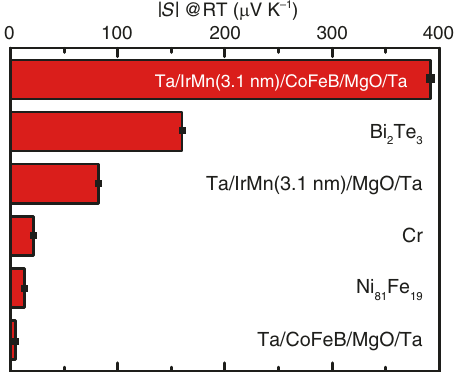
Fig. 5 Seebeck coef fi cients of various materials. The Seebeck coef fi cient of IrMn-based magnetic multilayer in comparison with conventional thermoelectric materials and magnetic materials in absolute value at room temperature. The values for Bi 2 Te 3 , Cr and Ni 81 Fe 19 are taken from refs. 5,13,44 respectively. A direct comparison of the Seebeck voltage measured as a function of temperature on multilayer samples with and without CoFeB layer is shown in Supplementary Note 14 and Supplementary Fig. 11.